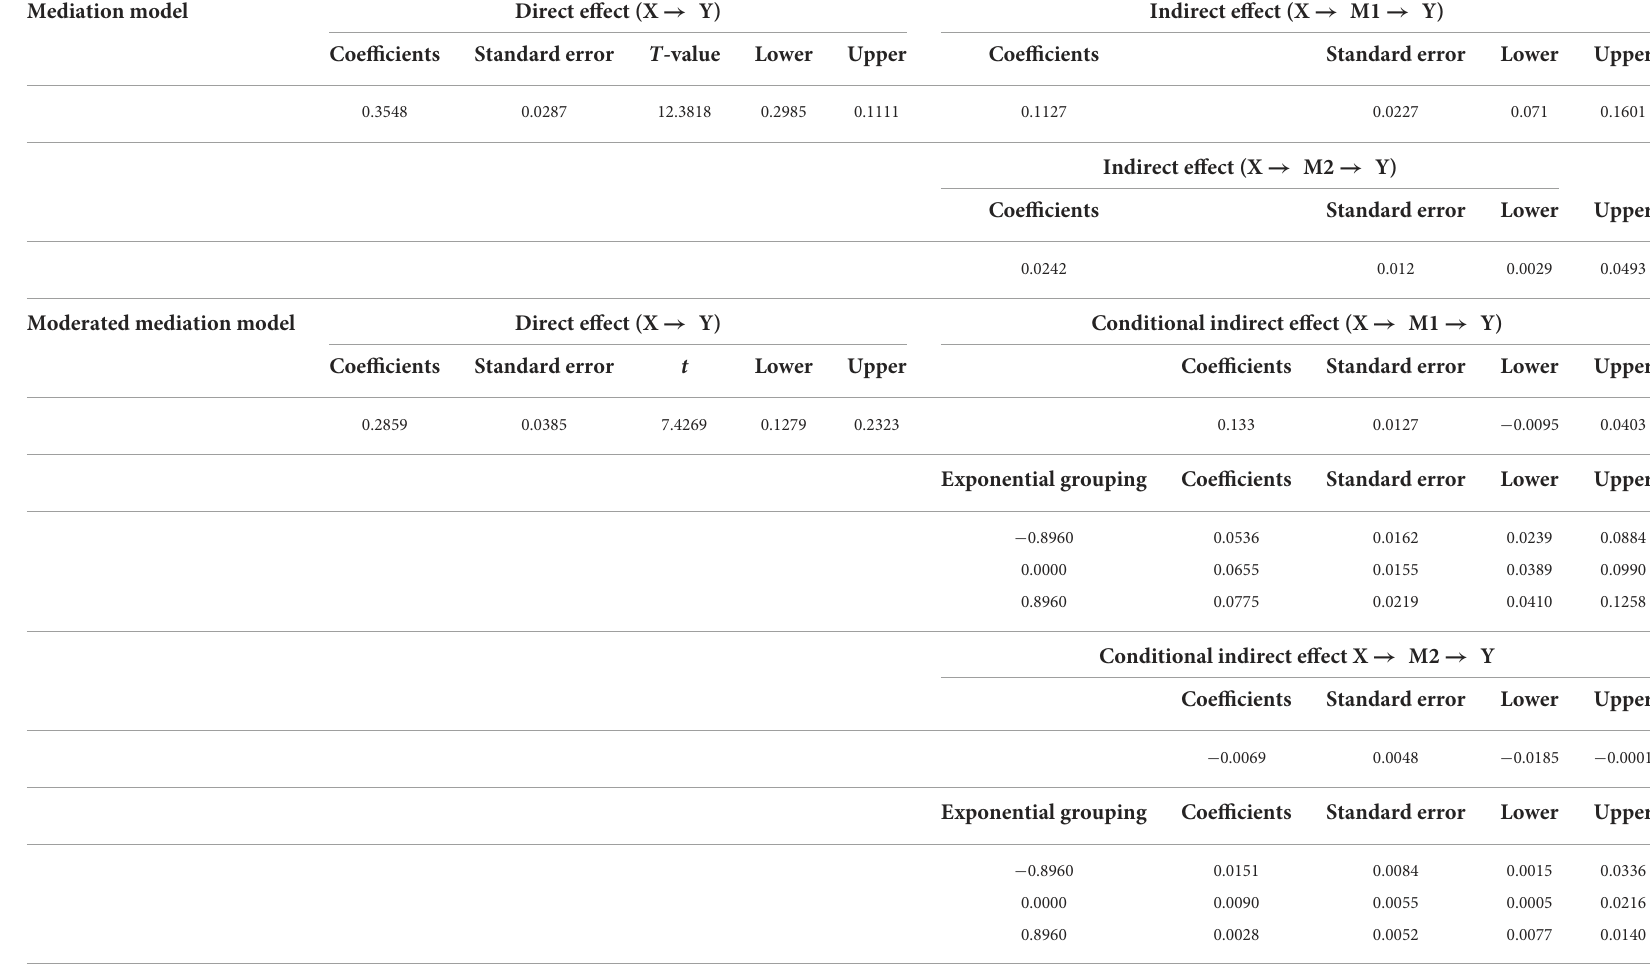
TABLE 6 Direct, indirect, and conditional indirect effects of X on